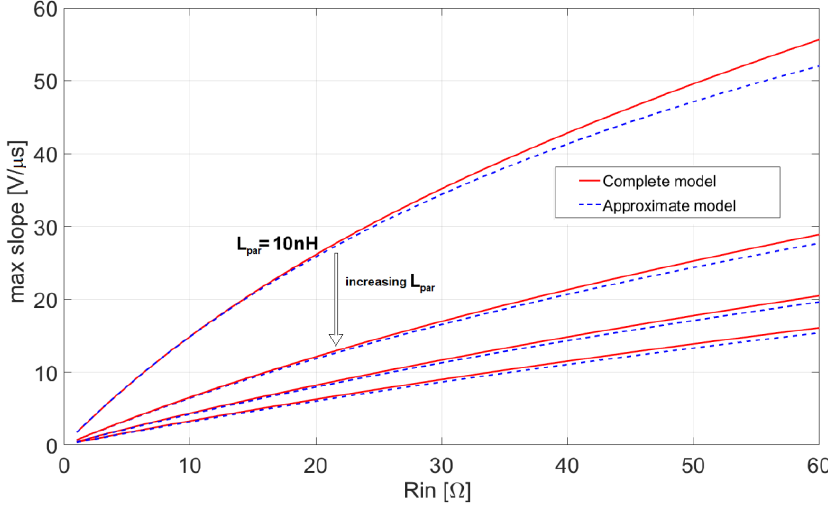
Figure 9. Maximum slope of the leading edge of the output pulse for the voltage-mode approach (13) compared with its approximation (22), with L par = 10 nH, 40 nH, 70 nH, 100 nH, C in = 0.5 pF, and BW = 0.5 GHz.